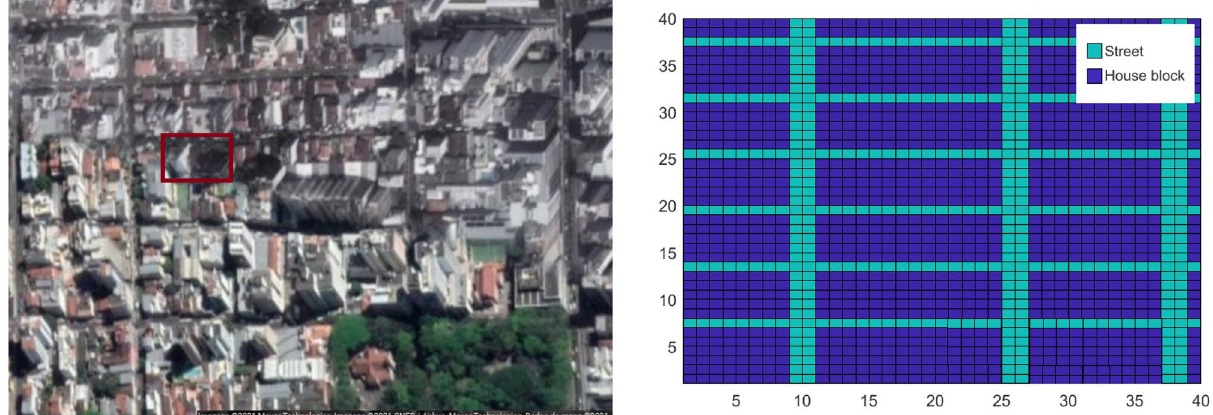
Figure 3. On the left, satellite view of a neighborhood of Juiz de Fora - Brazil obtained from Google Maps. On the right, numerical representation of the map as a 40 where the localized liberation of genetically modified mosquitoes happens as described on the Numerical results